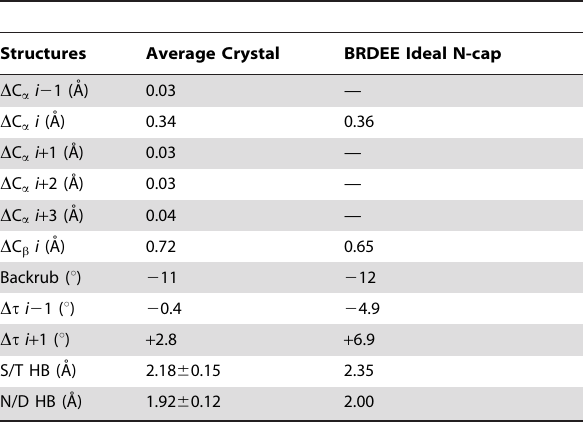
Table 1. Backrub changes for Ser/Thr vs. Asn/Asp a -Helix N-